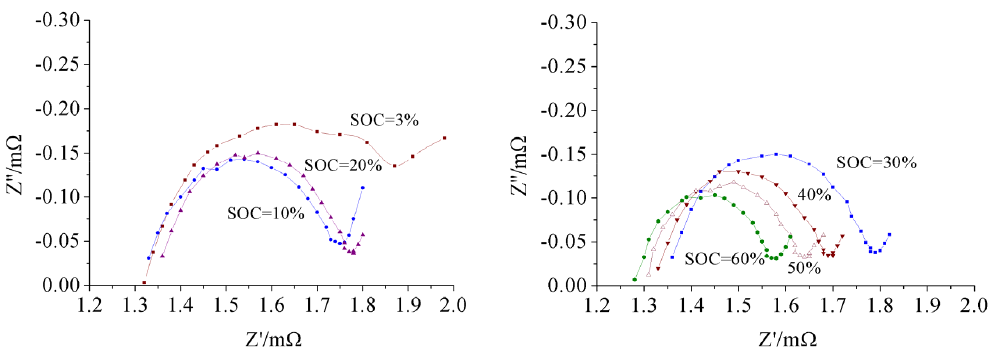
Figure 2. EIS of LiMn2O4 battery at various